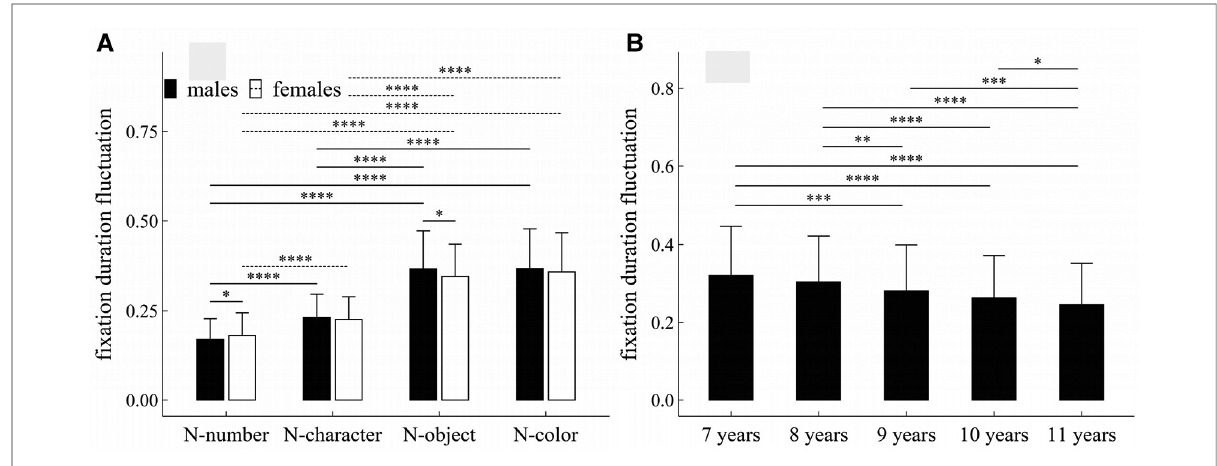
Figure 3 summarized the results of post-hoc multiple comparisons and indicated that: (1) For males or females (see Figure 3A ), task N-number required more regression counts